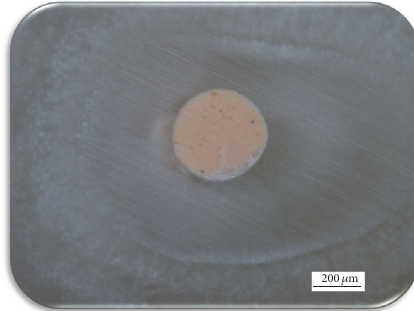
Figure 1: A representative cross section of a root canal filling using the cold lateral condensation technique (CLC Group), section A.